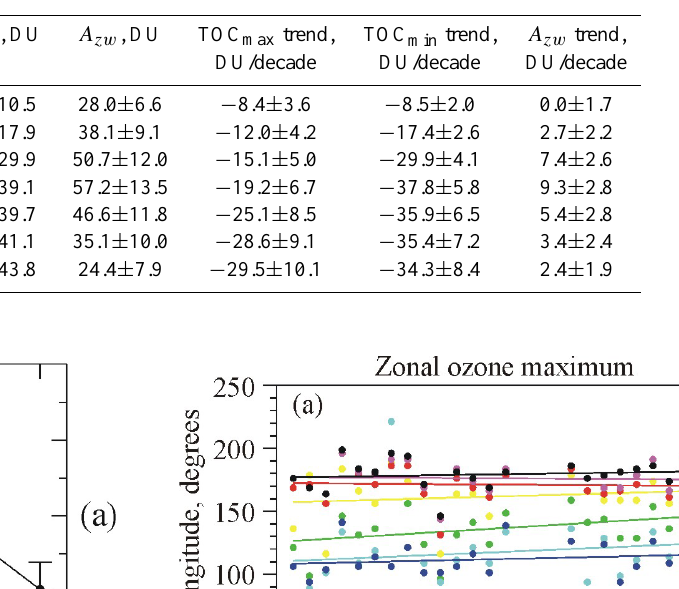
Table 1. September–November mean characteristics of the quasi-stationary TOC distribution at seven latitudes from 50 ◦ S to 80 ◦ S averaged over 1979–2005.